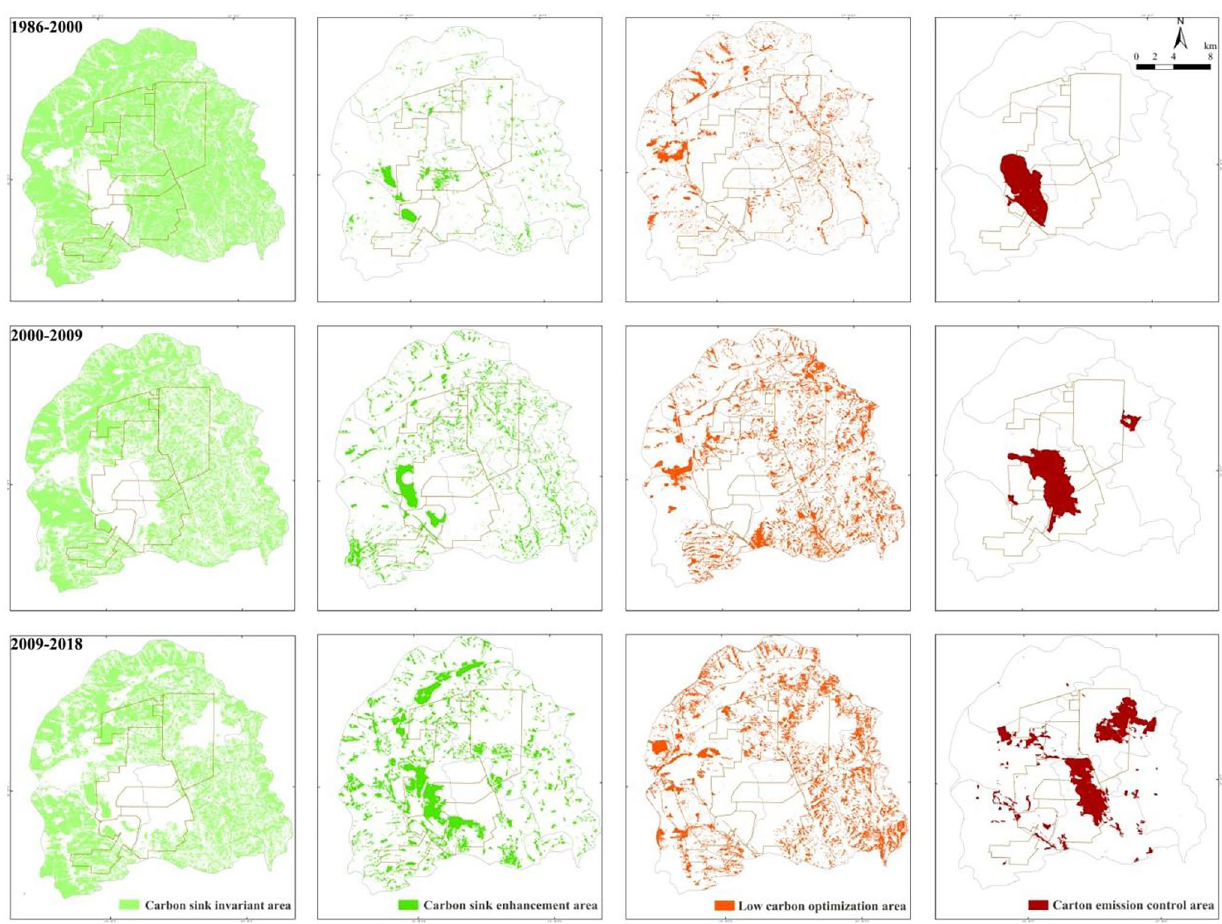
Fig. 4 Carbon functional areas in Pingshuo mining area from 1986 to